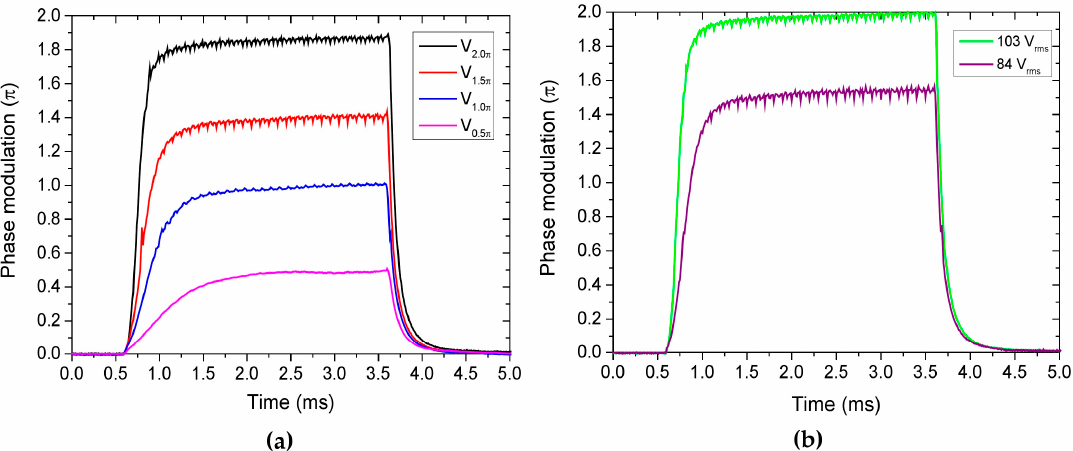
Figure 7. Measurements of response time in the RM7 cell for operating phase modulations: ( a ) Phase modulation voltages according to Table 2; ( b ) High phase modulation voltages corresponding to phase modulations of 1.5 π and 2.0 π .